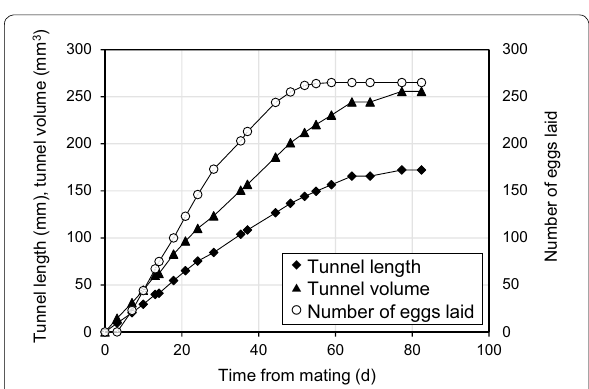
Fig. 5 Time courses of the length and volume of oviposition tunnels of individual F1 and the time course of the number of eggs laid